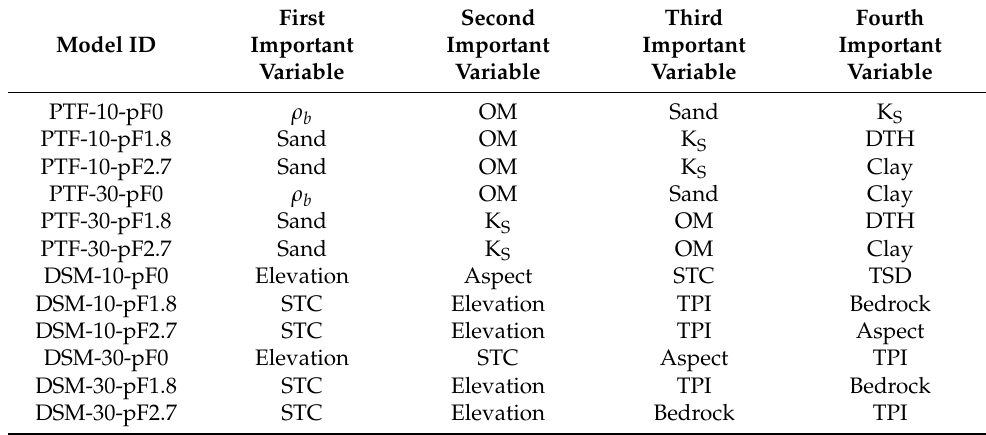
Figure 3. Averaged variable importance of 30 explanatory variables. Table 3. Four primary important variables of the twelve developed models.